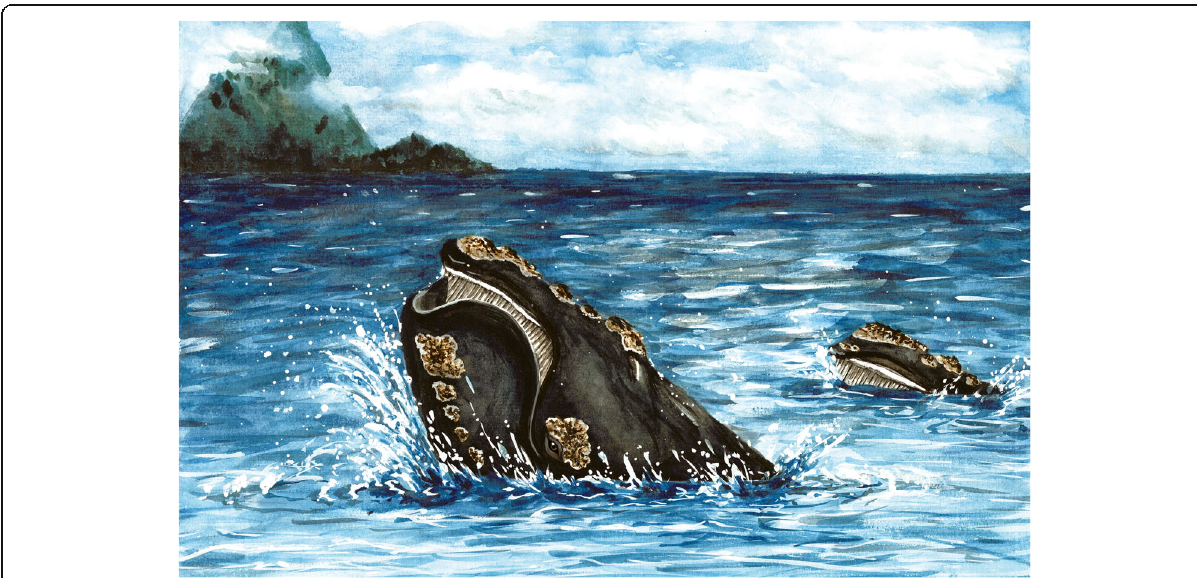
Fig. 3 Artistic reconstruction of tropical Eubalaena in the Pleistocene of Taiwan (©Lab of Evolution and Diversity of Fossil Vertebrates, National Taiwan University; illustrated by Chang-Han